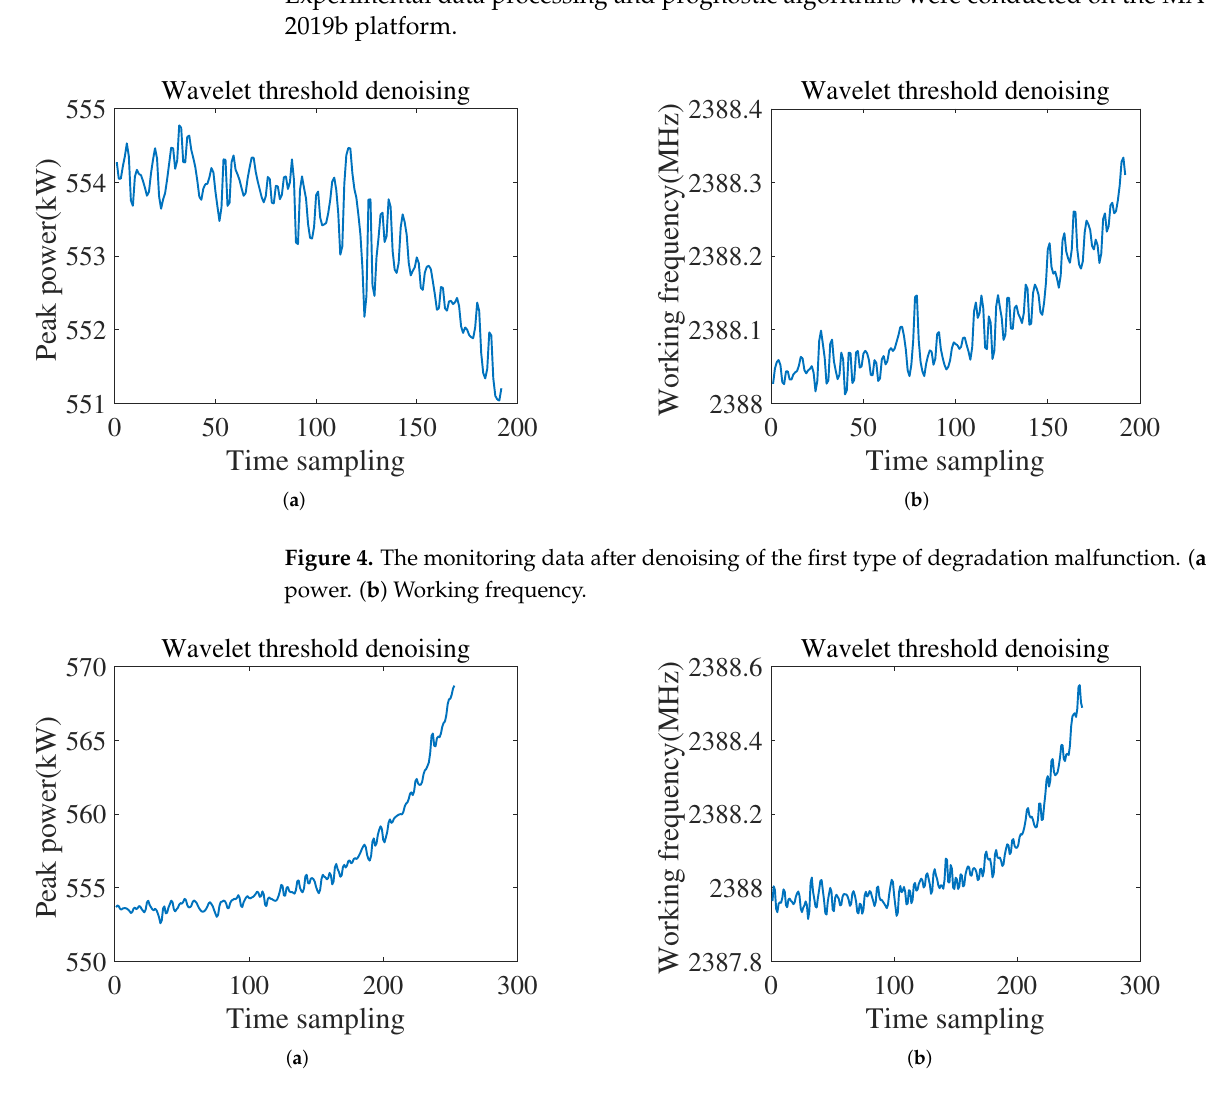
Figure 5. The monitoring data after denoising of the second type of degradation malfunction. ( a ) Peak power. ( b ) Working